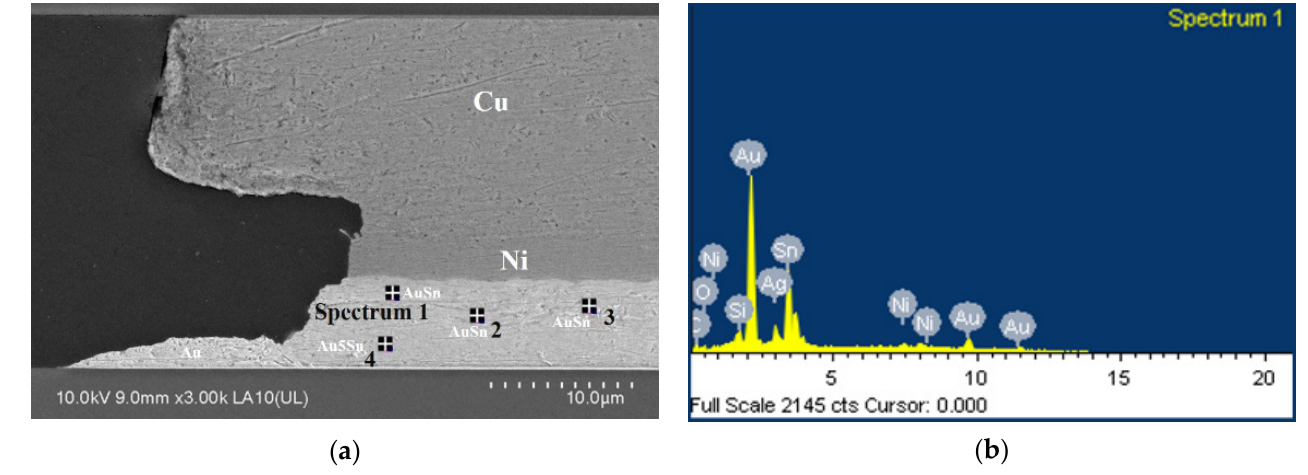
Figure 3. ( a ) the cross-sectional image of Au/Sn/Ni/Cu micro joint. ( b ) Au effective concentration.